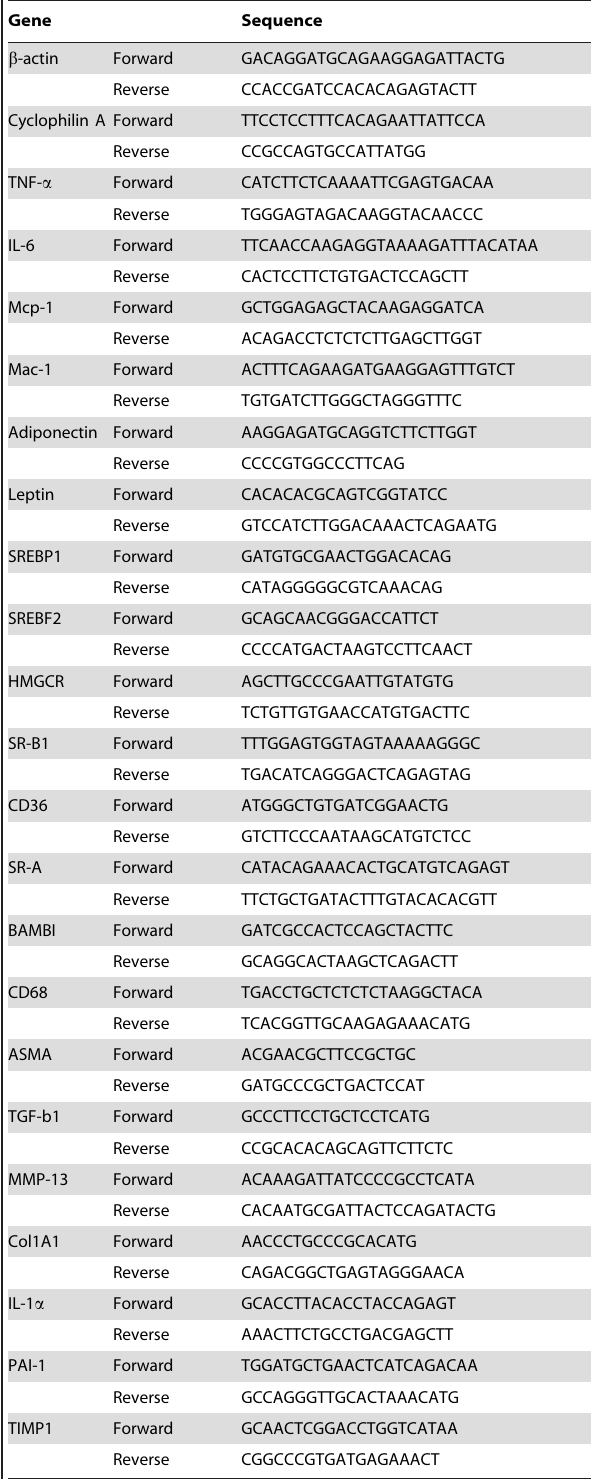
Table 1. Primer sequences for quantitative